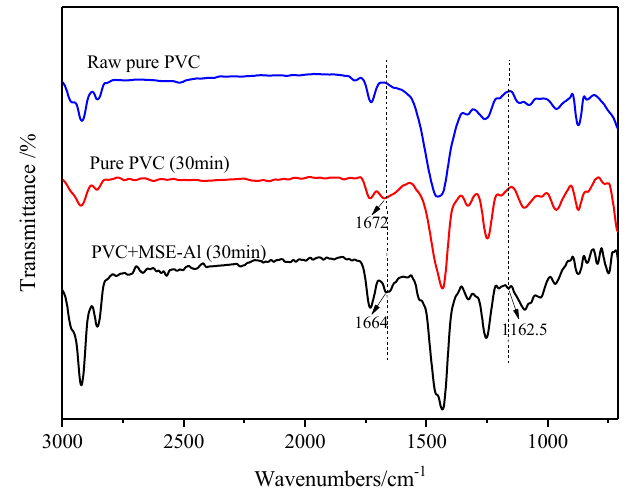
Figure 10. FTIR spectra of pure PVC and PVC stabilized by 4 phr of MSE-Al (heated at 180 °C for 30 min).